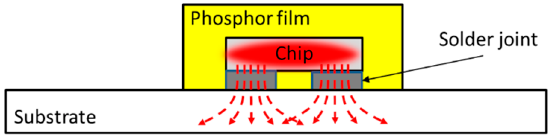
Figure 5. Illustration of the heat transfer path in a CSP LED.